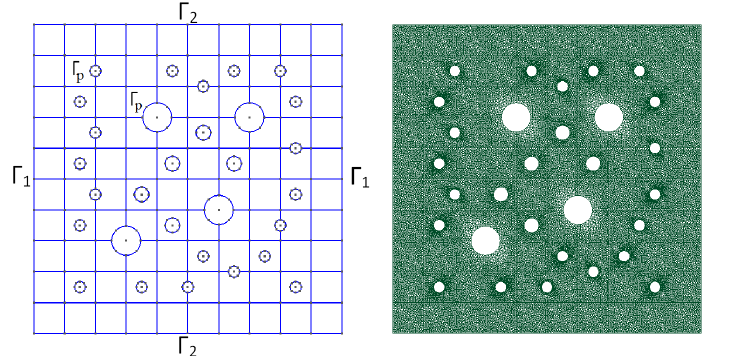
Figure 4. Perforated domain with coarse ( left ) and fine grids ( right ).